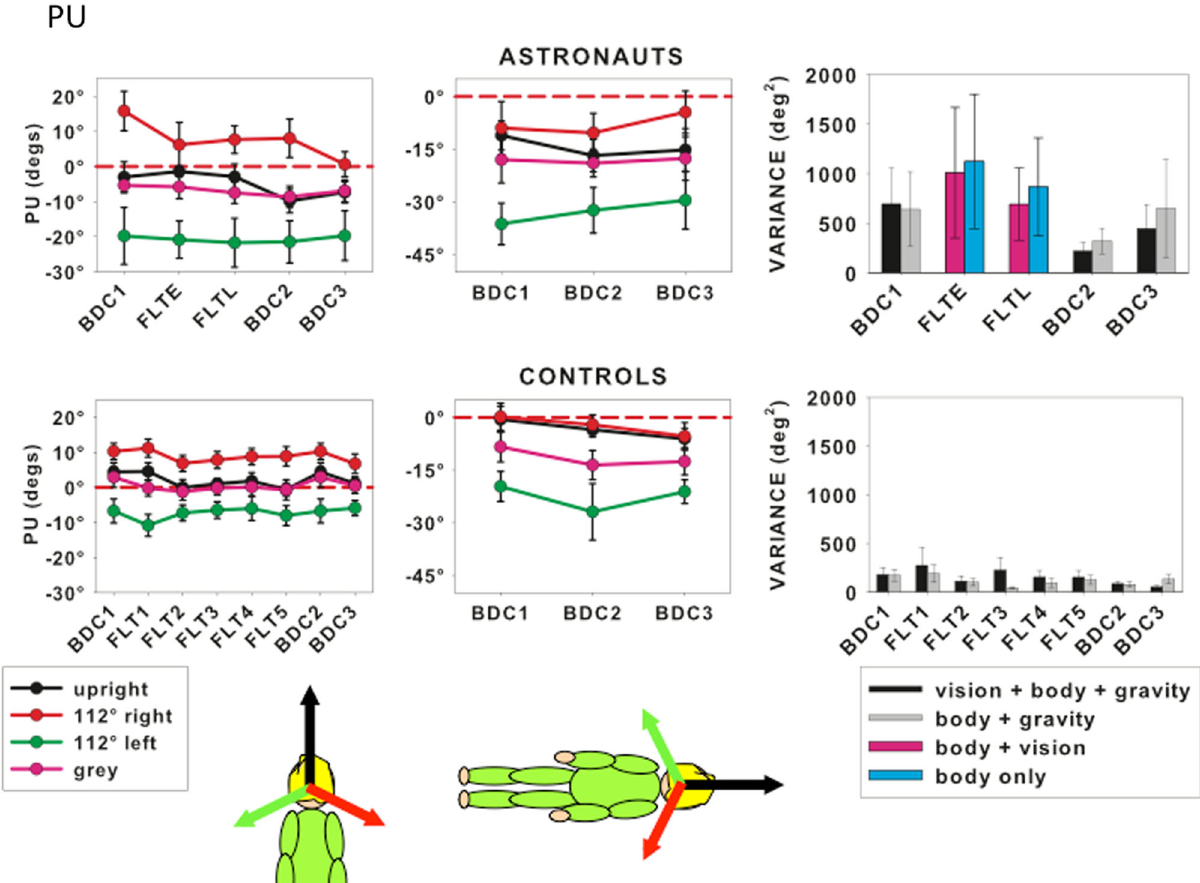
Fig. 2 The perceptual upright for astronauts ( top row ) and control participants ( bottom row ). Astronaut data from early (FLTE) and late in fl ight (FLTL) are shown together with the three BDC measurements. Right-side-down experiments ( middle column ) were only performed in the BDC sessions. Format as for Fig. 1. Variances for the in- fl ight measures correspond to “ body only ” when performed against a gray background ( pale blue ) and “ body + vision ” when upright visual cues were provided ( purple bars